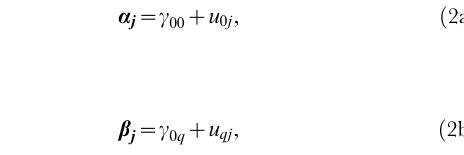
Figure S1 Histograms of the density of species centroid shifts in